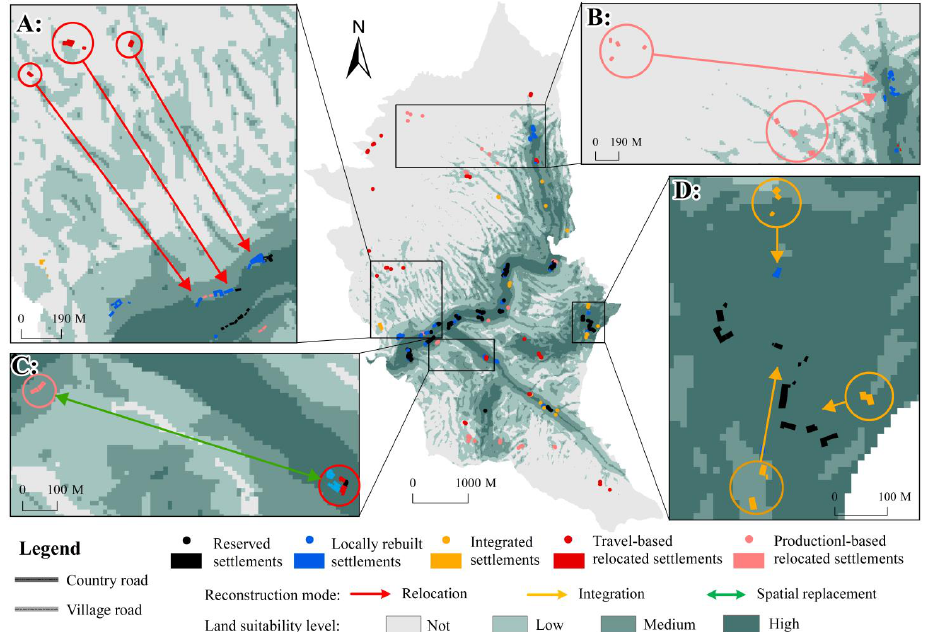
Figure 4. Spatial distributions of rural settlements under different optimization types and optimization modes. Note: ( A ) represents the relocation direction of travel-based relocated settlements. ( B ) represents the relocation direction of production-based relocated settlements. ( C ) represents the relocation direction of spatial replacement mode. ( D ) represents the relocation direction of integrated settlements.